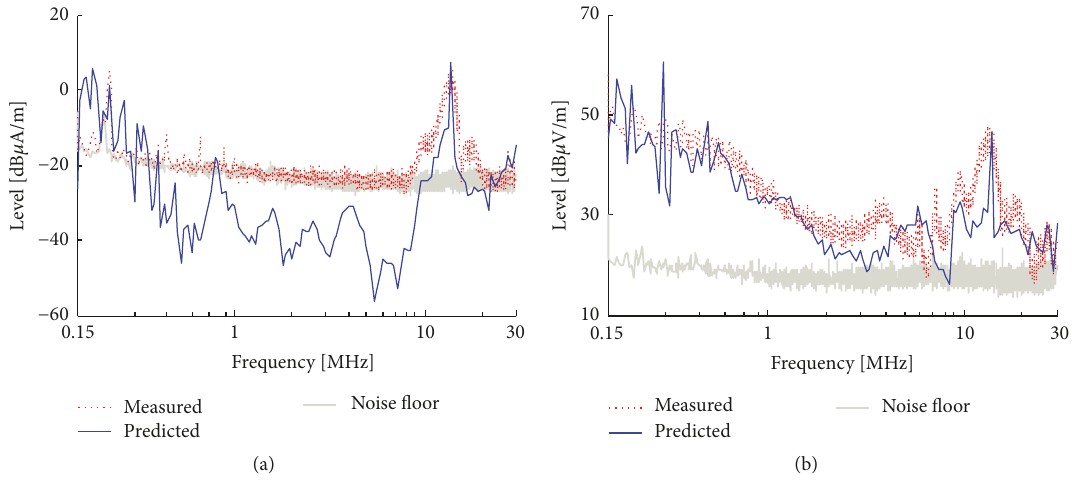
Figure 8: Predicted and measured EMI: (a) magnetic field; (b) electric